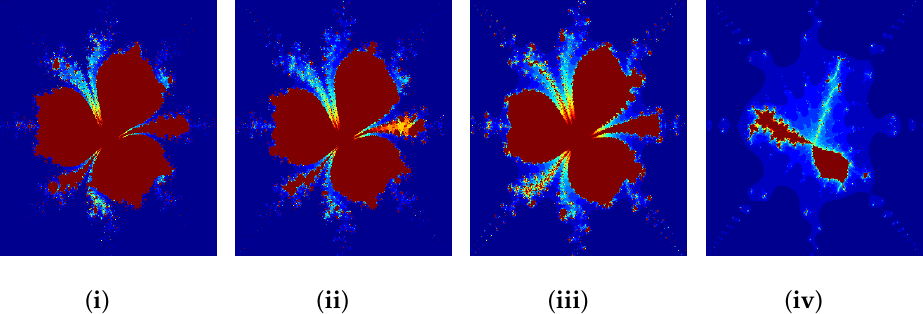
Figure 13. Quintic Julia sets in ( i ) Noor-orbit; ( ii ) Ishikawa-orbit; ( iii ) Mann-orbit; ( iv )